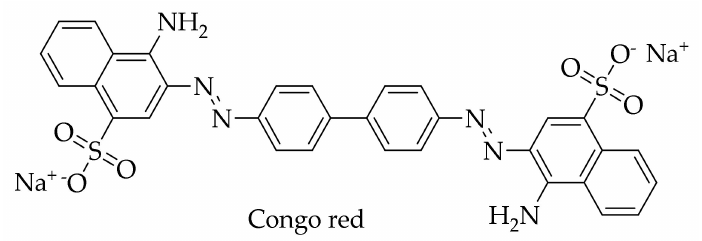
Figure 5. Structure of Congo red